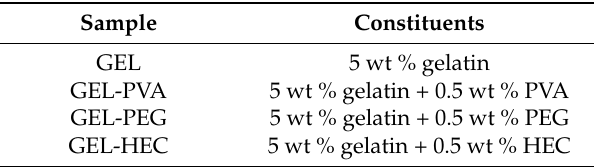
Table 1. Chemical structure of